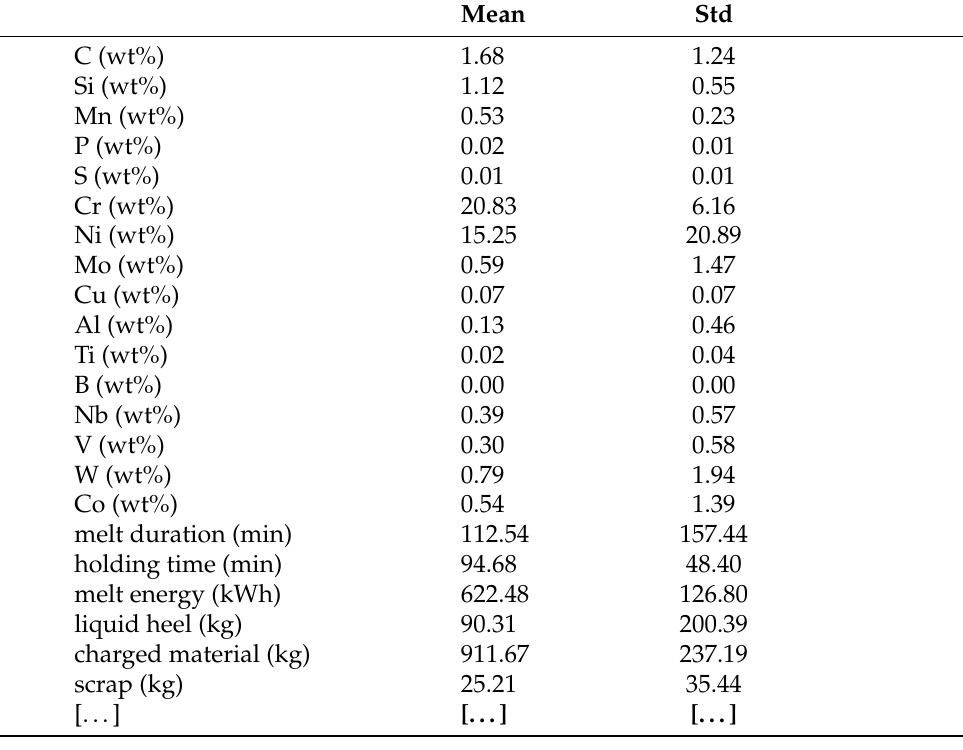
Table 1. Abstract of the input data used for model creation.